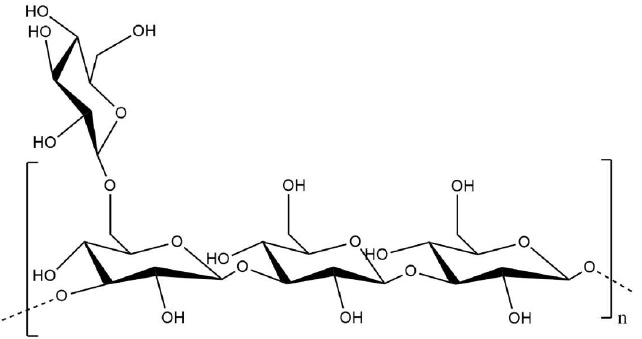
Figure 6. The chemical structure of grifolan. The pharmacological activities of G. frondosa glucans have been studied for more